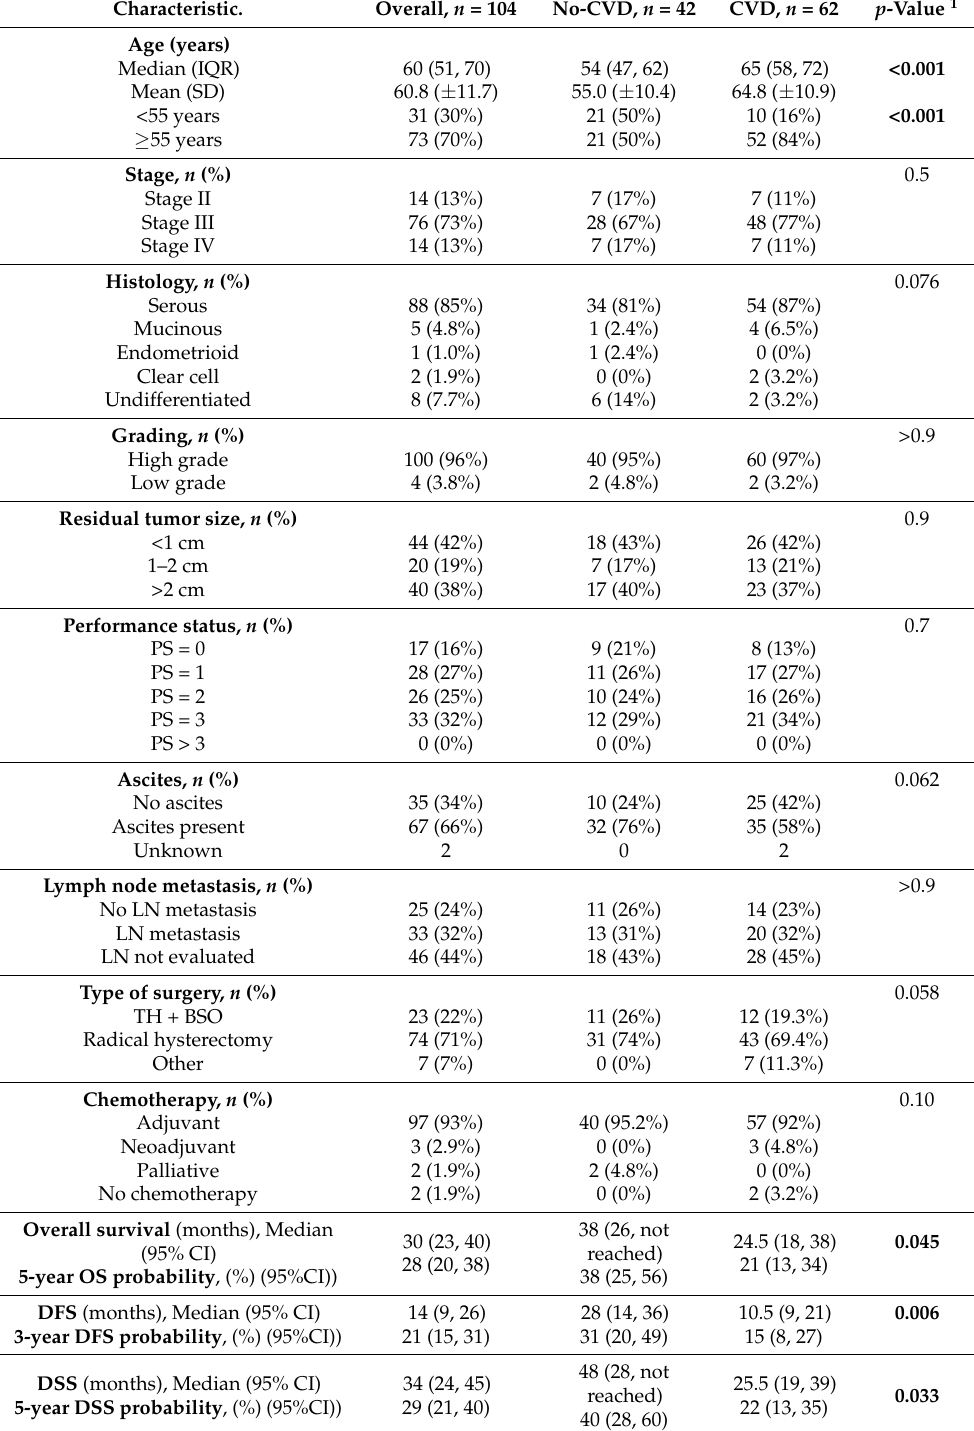
Table 1. Characteristics of the patient population and comparison of the CVD and No-CVD groups on different